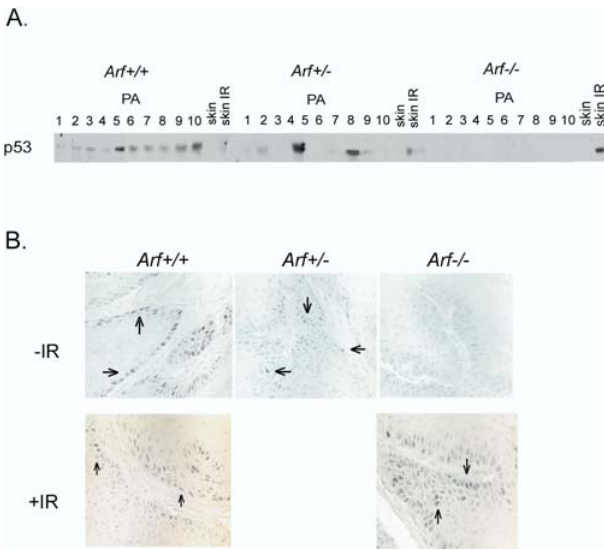
Figure 3. Reduced p53 Expression in Skin Tumors from p19 Arf -Deficient Mice (A) Western blot analysis of nuclear lysates from skin tumors from p19 Arf (Arf) þ / þ , p19 Arf þ / (cid:1) , and p19 Arf (cid:1) / (cid:1) mice using p53-specific anti- body. PA, papilloma; skin IR, irradiated normal skin (B) p53 immunostain of paraffin-embedded skin tumor sections from p19 Arf þ / þ , p19 Arf þ / (cid:1) , and p19 Arf (cid:1) / (cid:1) mice (arrows indicate positive stained cells) (top). p53 immunostain of irradiated papillomas (IR) from p19 Arf þ / þ and p19 Arf (cid:1) / (cid:1) mice (bottom). p53 is not detected in normal skin or tumors from p19 Arf (cid:1) / (cid:1) mice, but is induced by irradiation in both normal and tumor cells from p19 Arf (cid:1) / (cid:1) mice. DOI: 10.1371/journal.pbio.0020242.g003